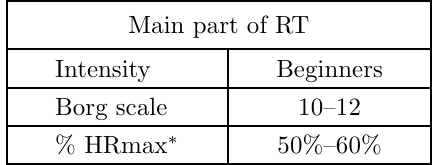
Table 1. Working load intensity parameters during the main part of RT